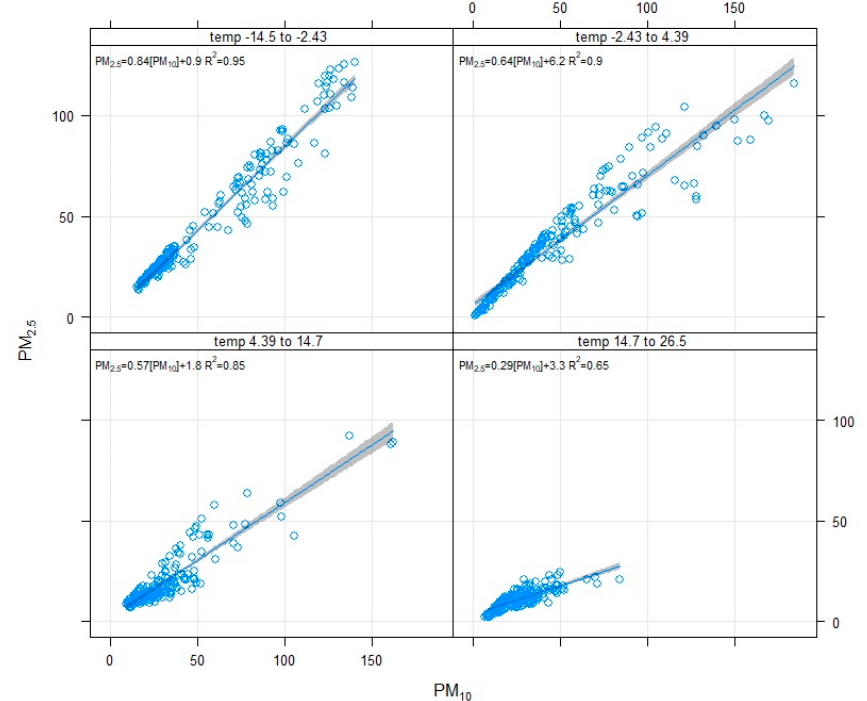
Figure 8. Scatter plot and MRA for PM 2.5 and PM 10 variables related to air temperature from all measurements in Zilina City (temp—temperature).